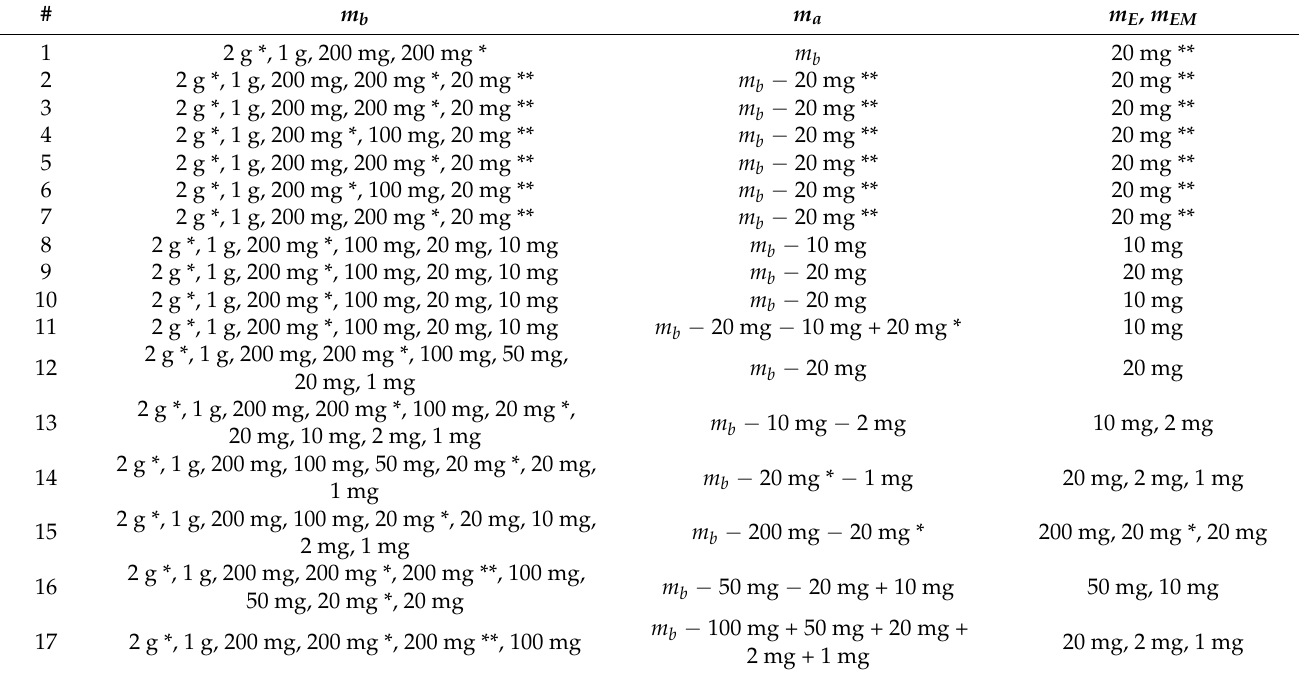
Table 3. Used standard weights in each sequence and by weighing method, * and ** represent marking on the weight surface used to distinguish weights with the same nominal value.